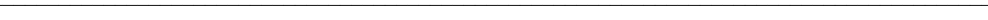
Fig. 5. Selected conodonts from the Kalana section. As positional homology of elements in an apparatus has been determined only for few taxa, the traditional Pa, Pb, Pc, M, Sa, Sb, Sc notation introduced by Sweet & Schönlaub (1975) is followed here. Scale bar represents 100 μ m. A , D , O , Aulacognathus cf. antiquus Bischoff: A, Sc element, GIT 738-1; D, Pa element (D1 – from above, D2 – from below), GIT 738-2; O, Pb element, GIT 738-3. B , C , E , G , Pranognathus tenuis (Aldridge): B, Pa